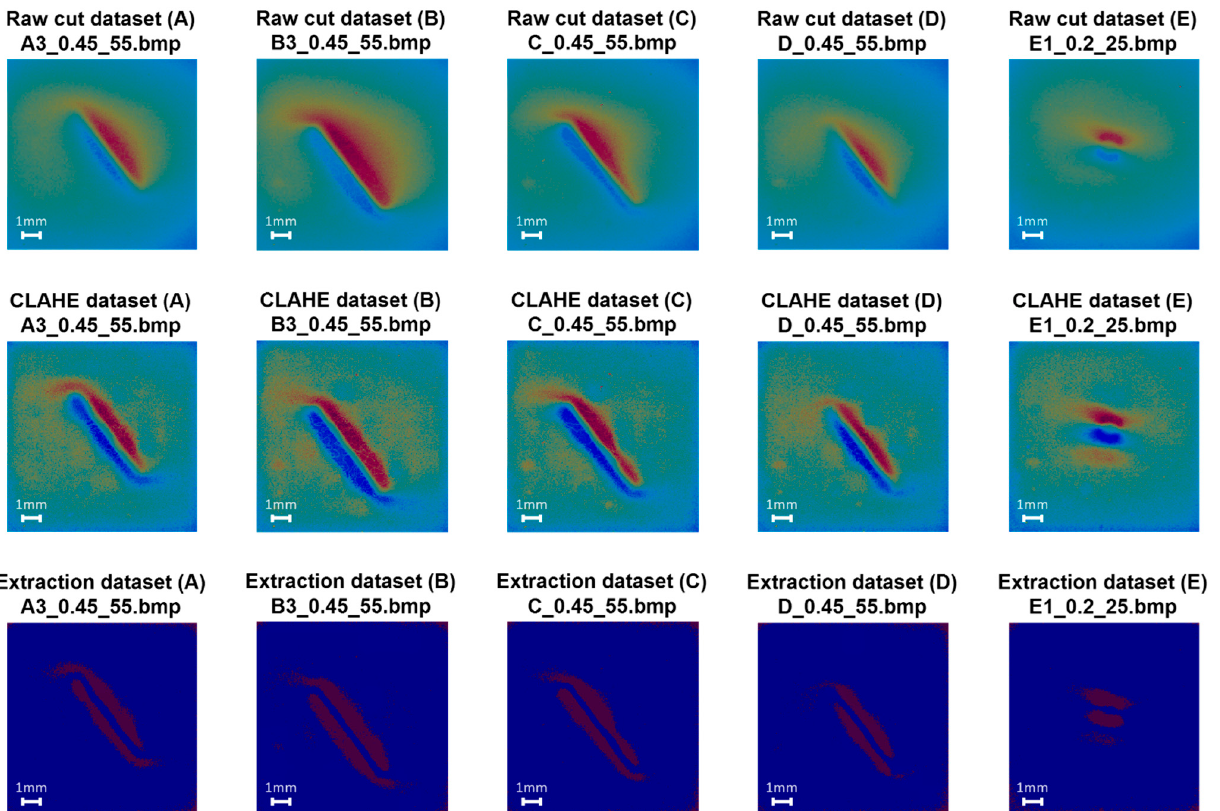
Figure 12. Score activation map for analyzing network behavior using occlusion sensitivity.